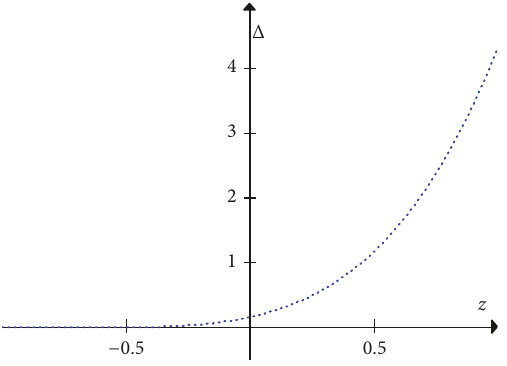
Figure 9: The plot of anisotropy parameter (Δ) versus redshift 𝑧